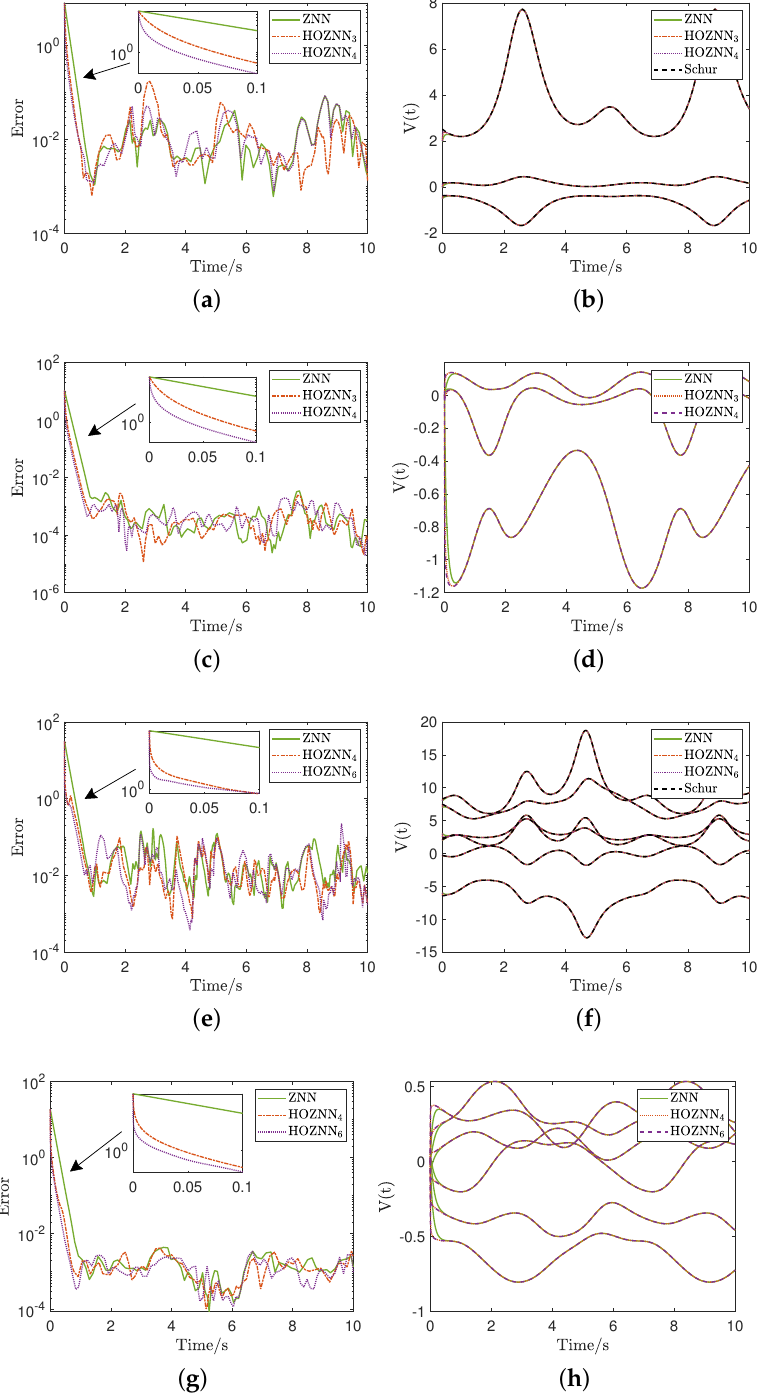
Figure 1. Trajectories of the HOZNN’s solutions and convergence in NEs Sections 4.1 and 4.2 under IC1 and IC2. ( a) NE Section 4.1 under IC1: convergence. ( b ) NE Section 4.1 under IC1: solutions trajectories. ( c ) NE Section 4.1 under IC2: convergence. ( d ) NE Section 4.1 under IC2: solutions trajectories. ( e ) NE Section 4.2 under IC1: convergence. ( f ) NE Section 4.2 under IC1: solutions trajectories. ( g ) NE Section 4.2 under IC2: convergence. ( h ) NE Section 4.2 under IC2: